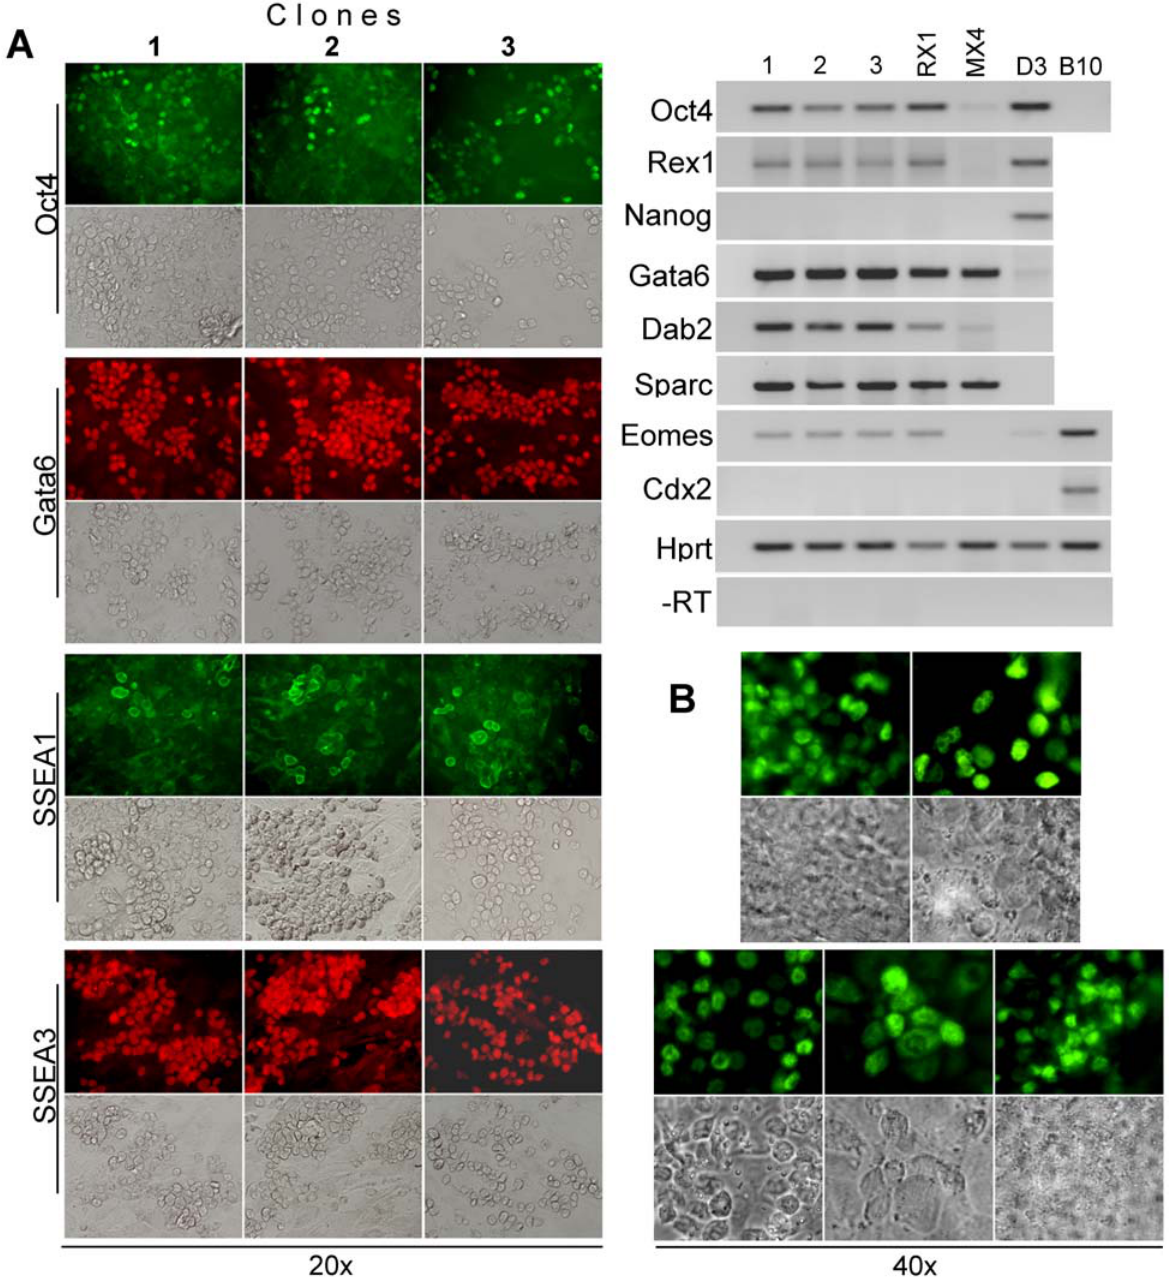
Figure 6. Lineage marker expression in clonal XEN-P cell lines. ( A ) Line RX1 was subcloned by stable transfection, and three different primary colonies were arbitrarily picked, expanded, and analyzed by indirect immunofluorescence (left; compare to Fig. 3) or RT-PCR (right; compare to Fig. 2C). ( B ) Line RX1 was subcloned by single-cell FACS deposition. 20 clones were analyzed for Oct4 expression (all positive), and 5 representative photos are